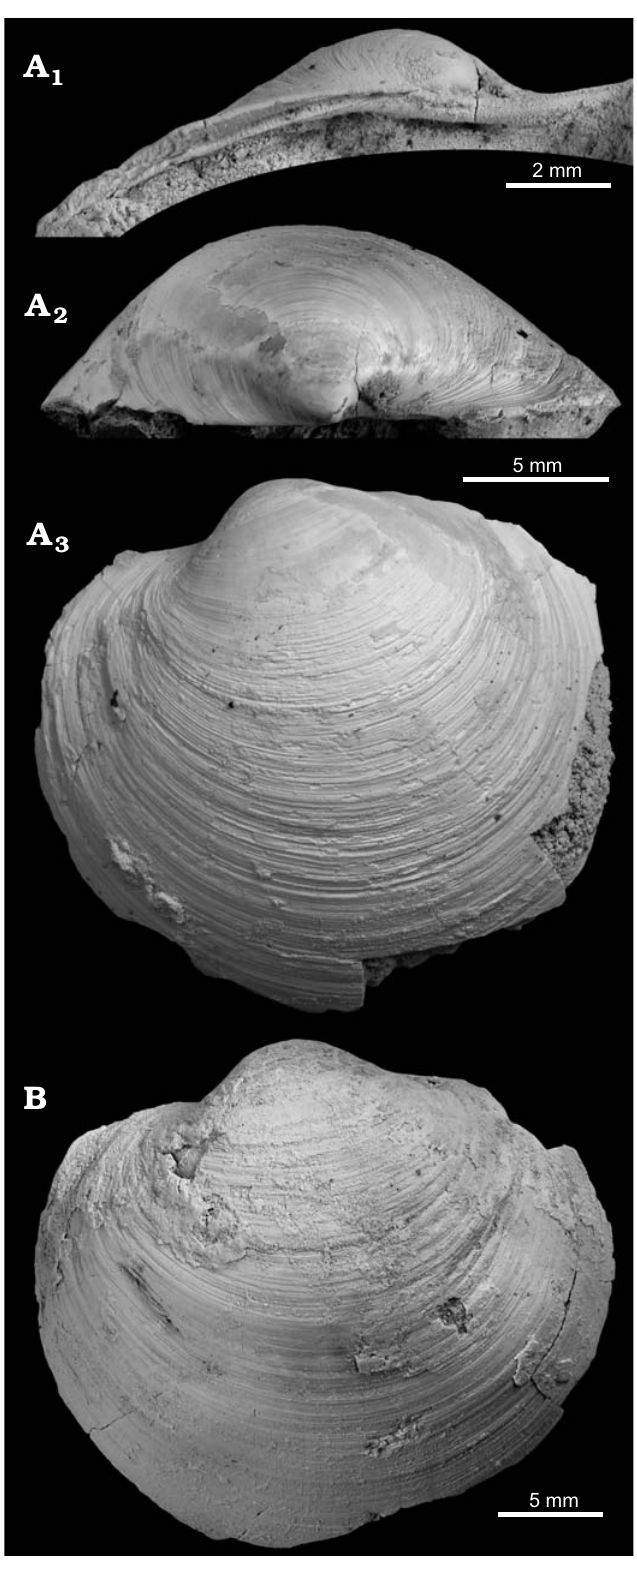
Fig. 9. The lucinid bivalve Anodontia sp. from the late Pliocene of Italy, Stirone River seep deposit. A . MGGC.22017, smaller specimen, close-up of edentulous hinge area of left valve (A 1 ), dorsal view (A 2 ), and view of outer side of left valve (A 3 ). B . MGGC.22018, larger specimen, left valve, exterior